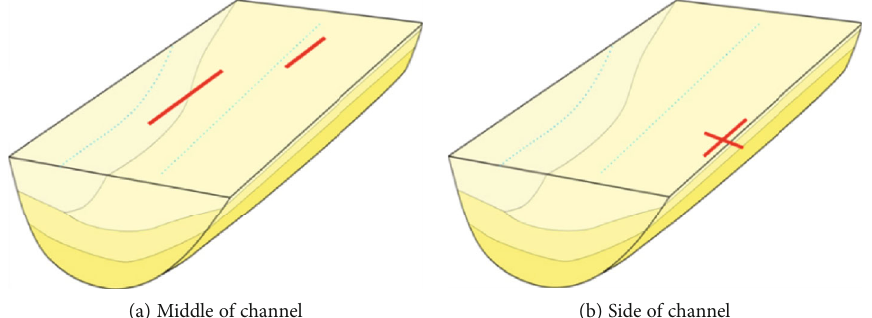
Figure 13: Channel sedimentary structure.